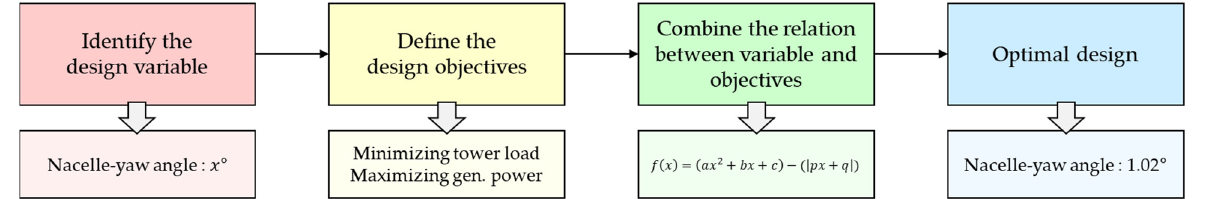
Figure 13. Flowchart of the multiobjective optimization method.